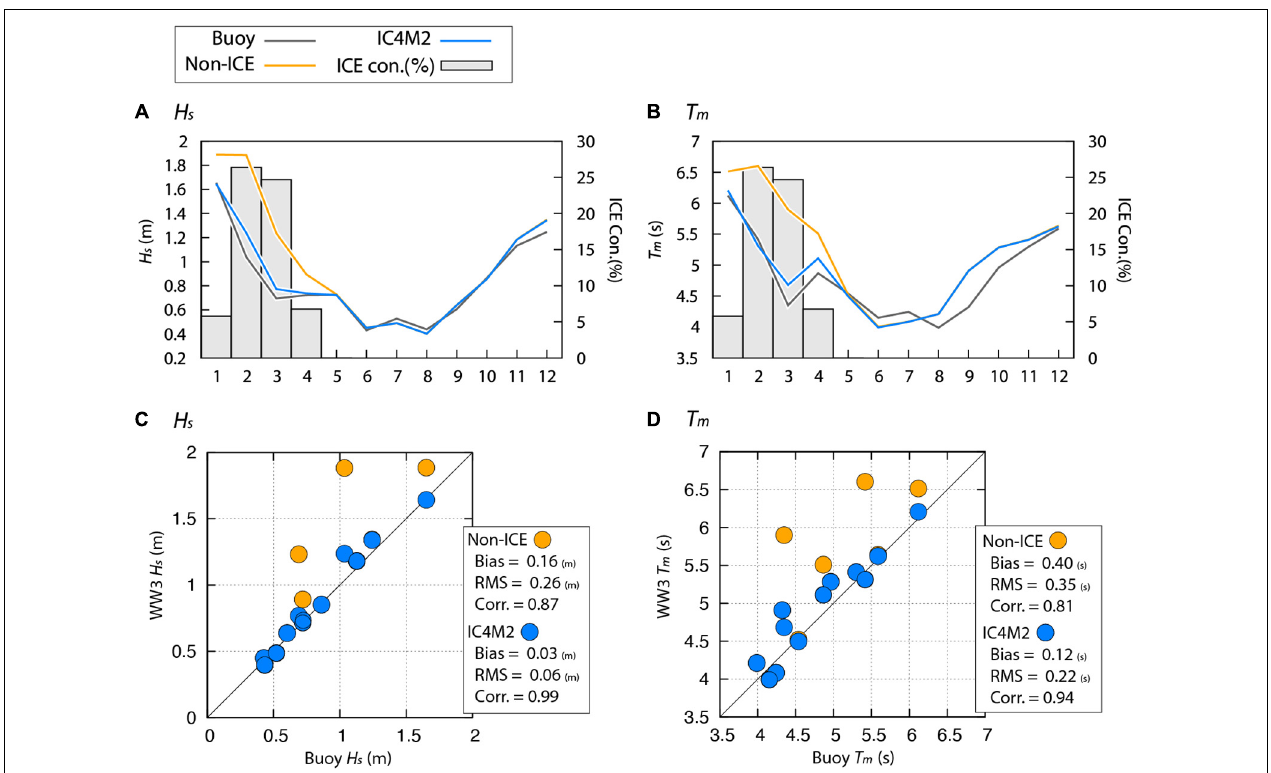
FIGURE 7 | (Upper panels) Temporal variations and (lower panels) scatter plots of monthly averaged (A,C) H s and (B,D) T m derived from the simulation and the buoy observation. Both simulations are modeled results with ST6. (A,B) Values are averaged each month from 2008 to 2010. The light gray bars represent the ice concentration in the coastal area around buoy (44 ◦ –46 ◦ N, 142.5 ◦ –145.5 ◦ E). (C,D) Statistical values are shown in the lower left corner of both panels. Note that the position of Non-ICE (orange circle) overlaps that of IC4M2 (light blue circle) for the open water